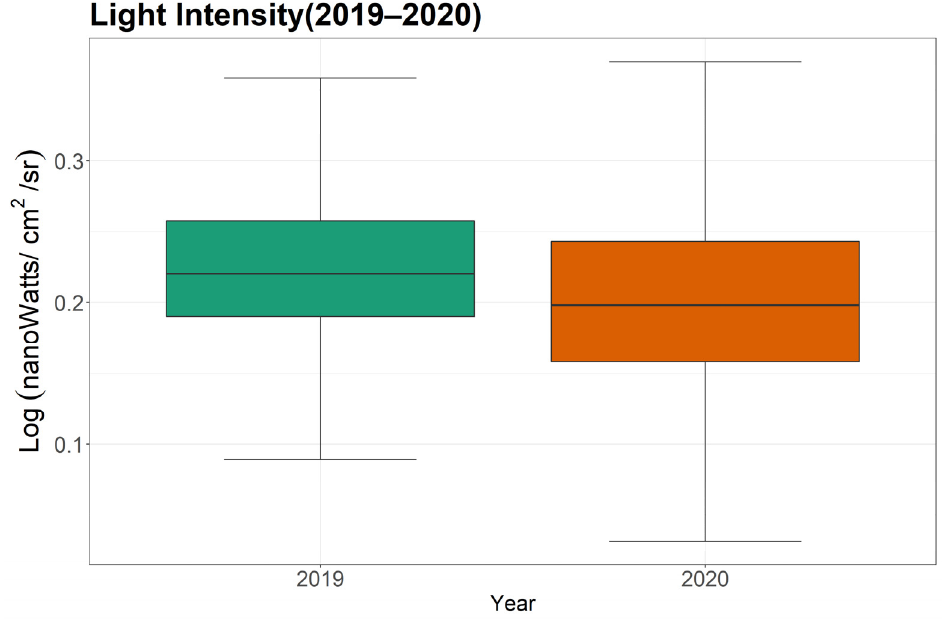
Figure 3. Comparison of night-time lights intensity between 2019 and 2020.